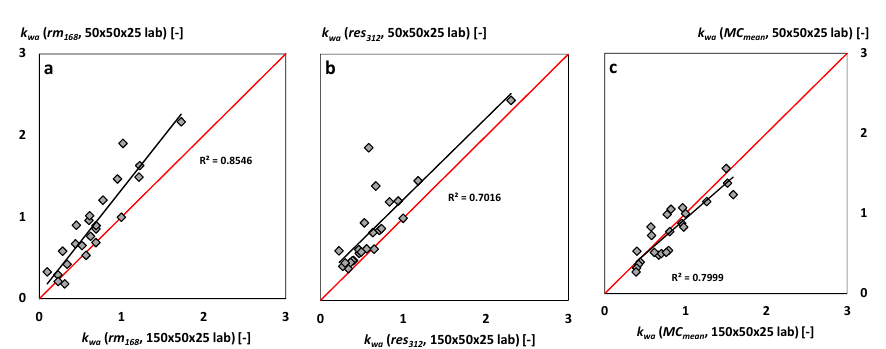
Figure 3. k wa factors based on rm 168 ( a ), res 312 ( b ) and MC mean ( c ) determined during floating tests versus respective k wa factors measured during submersion tests according to [5].